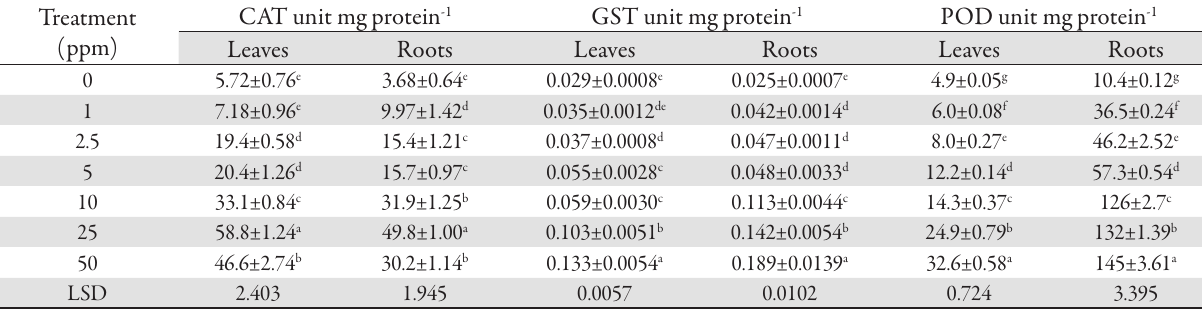
Tab. 2. Specific activities of antioxidant enzymes in leaves and roots of radish plants